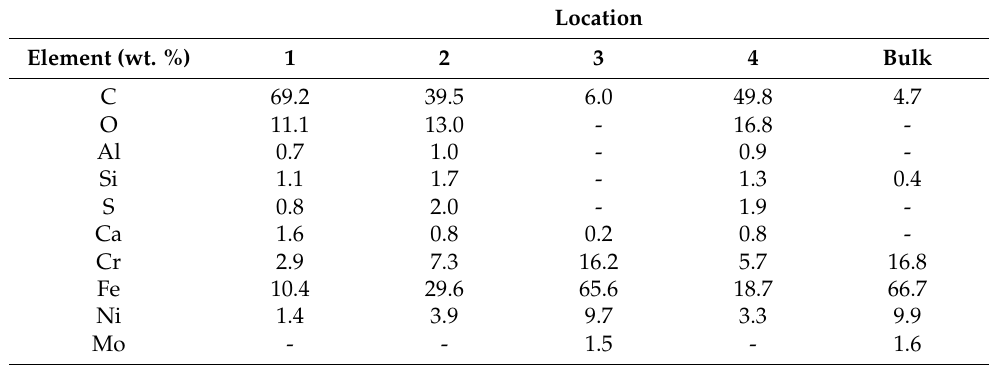
Table 6. EDX elemental analysis of locations shown in Figure 10A.